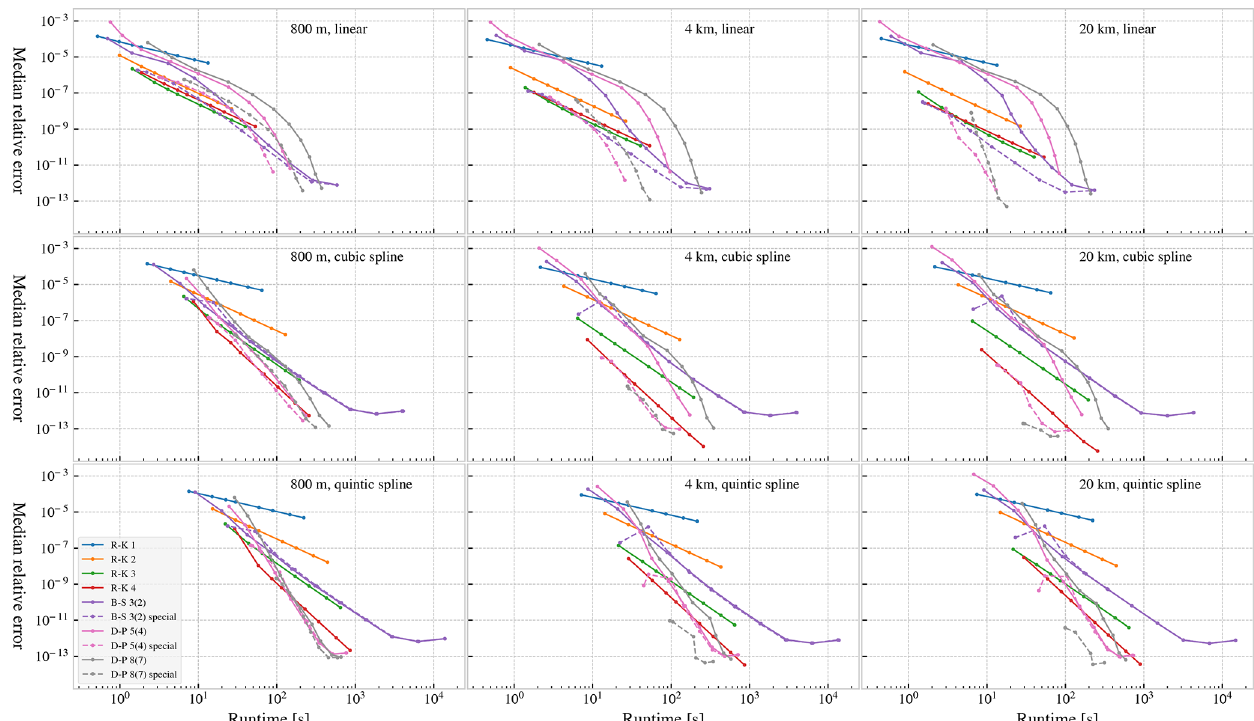
Figure B2. Same as Fig. 5, showing the median relative error, taken over all 10000 trajectories, except that the median error is shown as a function of simulation runtime, rather than the number of evaluations of the right-hand side of the